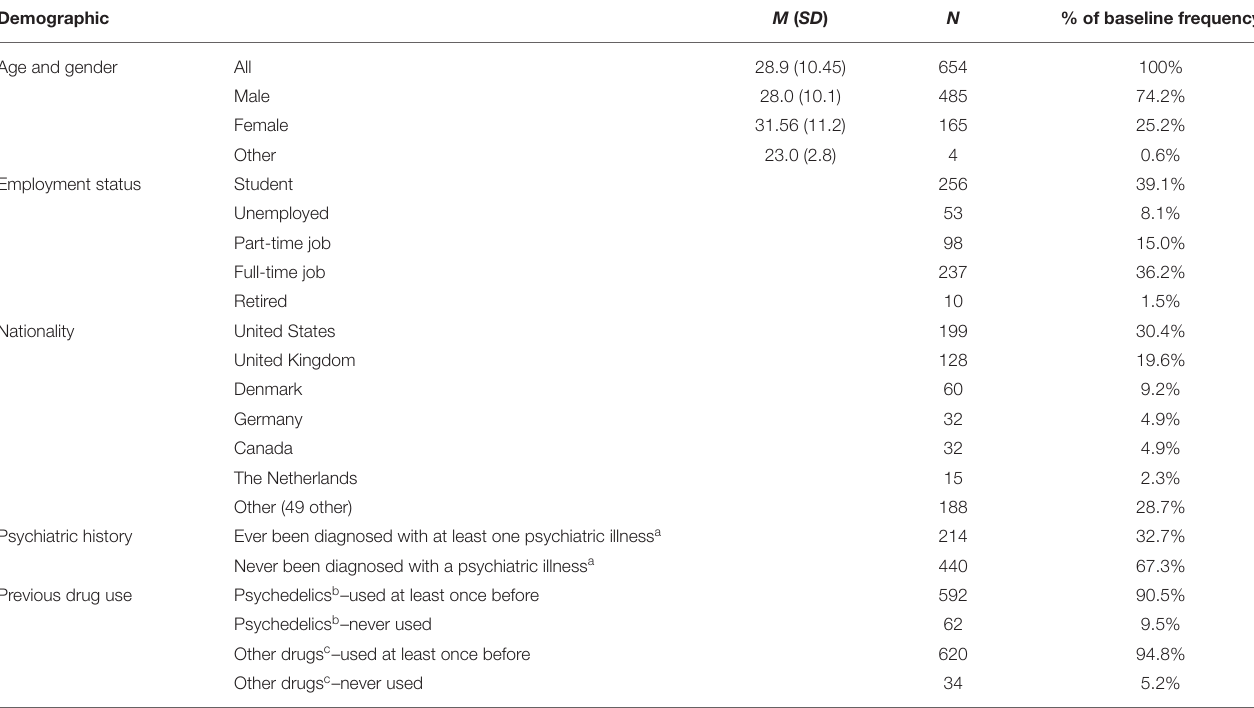
TABLE 2 | Demographic data collected at baseline (time point 1; TP1).